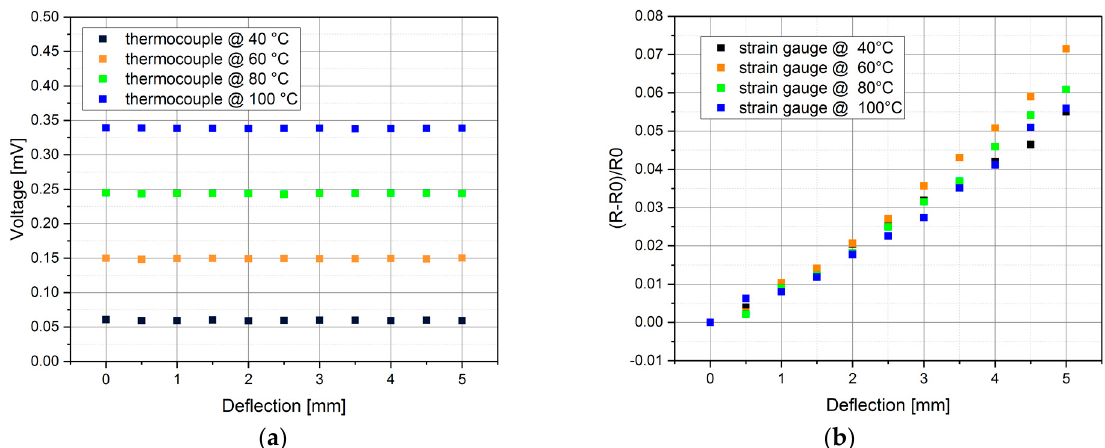
Figure 3. The sample was placed in a climatic chamber while a motorized stage deflected the substrate (5mm deflection over 100 mm); ( a ) Output of the thermocouple for temperatures of 40 up to 100 °C while the substrate was deflected five mm over a length of 100 mm, virtually no sensitivity to deformation can be observed; ( b ) Change of the strain gauge resistance during deflection of the substrate for temperatures of 40 up to 100